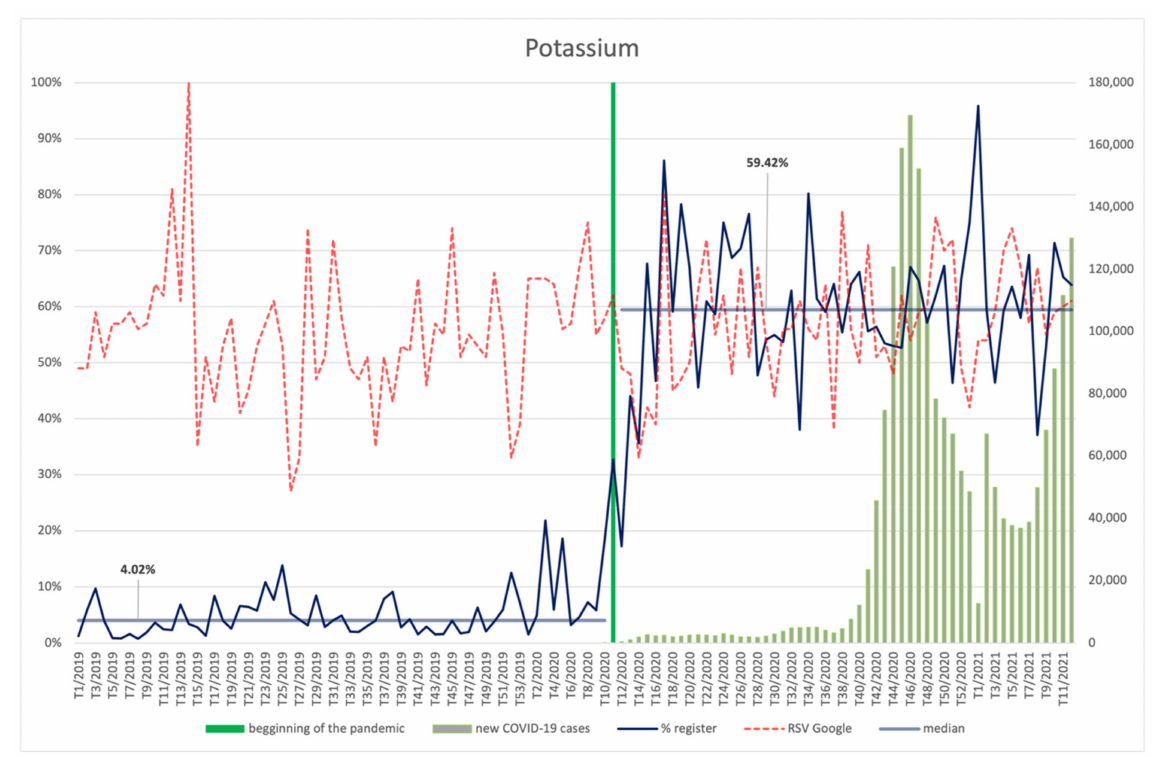
Figure 11. Comparison between the number of new registrations of products containing potassium, the number of COVID-19 cases, and the frequency of search for information on the ingredient in the Google browser.